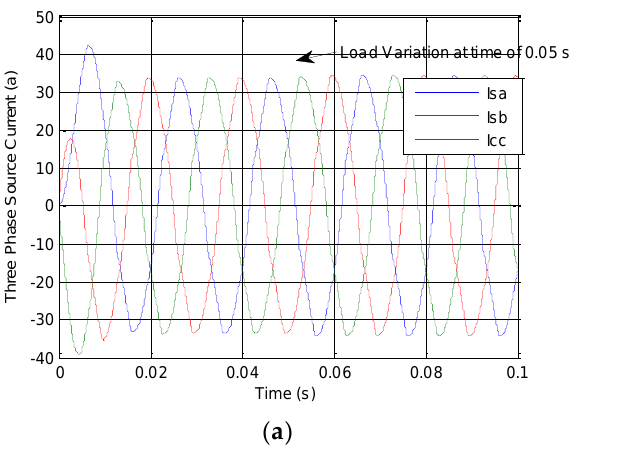
Figure 9. Simulated responses of three phase SSI-based SAPF connected at DRB—RL load with HCC and FLC: ( a ) Supply current, ( b ) load current, ( c ) compensation current, ( d ) THD, ( e ) V 2 DC link voltage, ( f ) V 1 DC link voltage, ( g ) SSI output voltage and ( h ) source voltage (V sa ) and source current (I sa ) of Phase A.